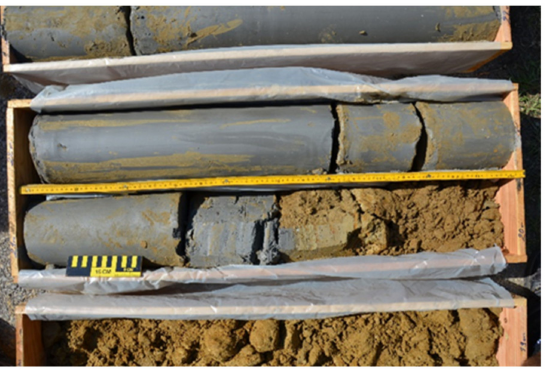
Figure 1. The 80 m drill cores from the geophysical test field at the Geological Survey of Austria.